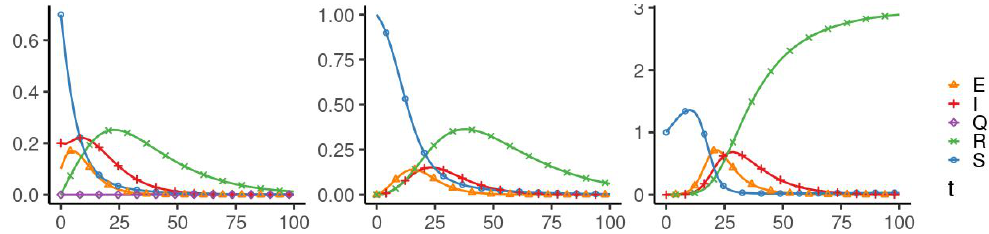
Figure 6. Experiment 1. Spread of the virus in three different clusters in an uncontrolled case.